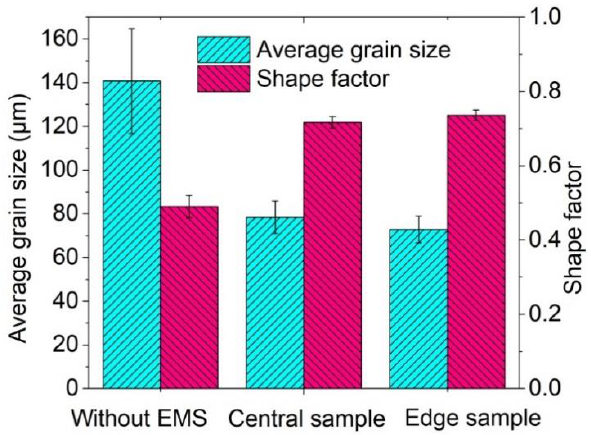
Figure 22. Average grain size and shape factor of the microstructure for the billet prepared without EMS and with the medium-level EMS.